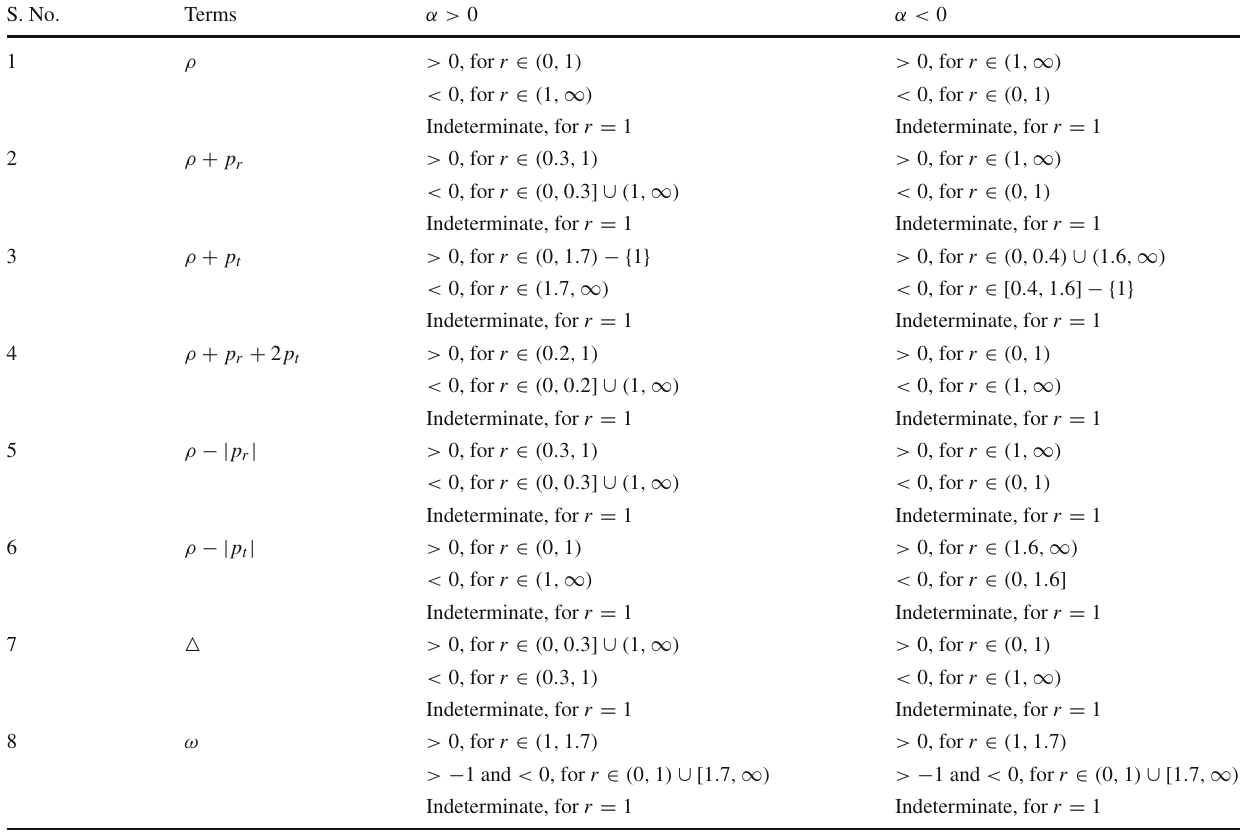
Table 8 Summary of results for φ( r ) = constant with n = − 2 S.